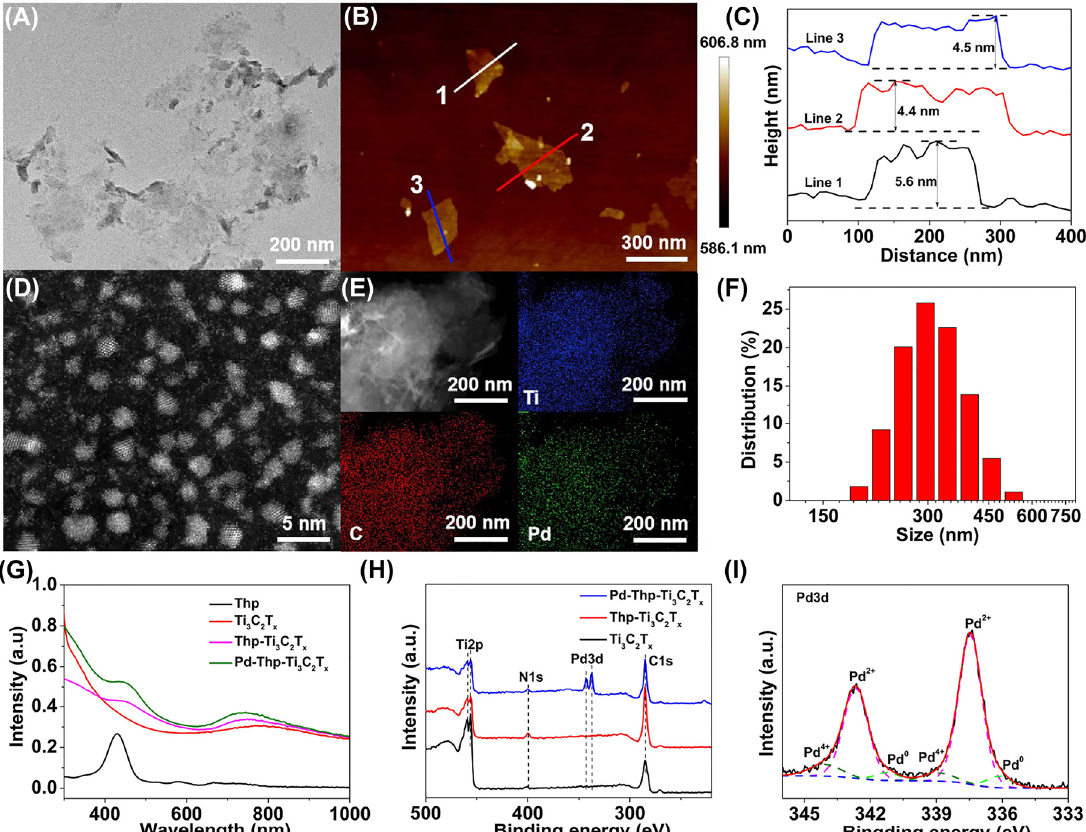
C T . (A) TEM images and (B) AFM image of Ti 3 2 x